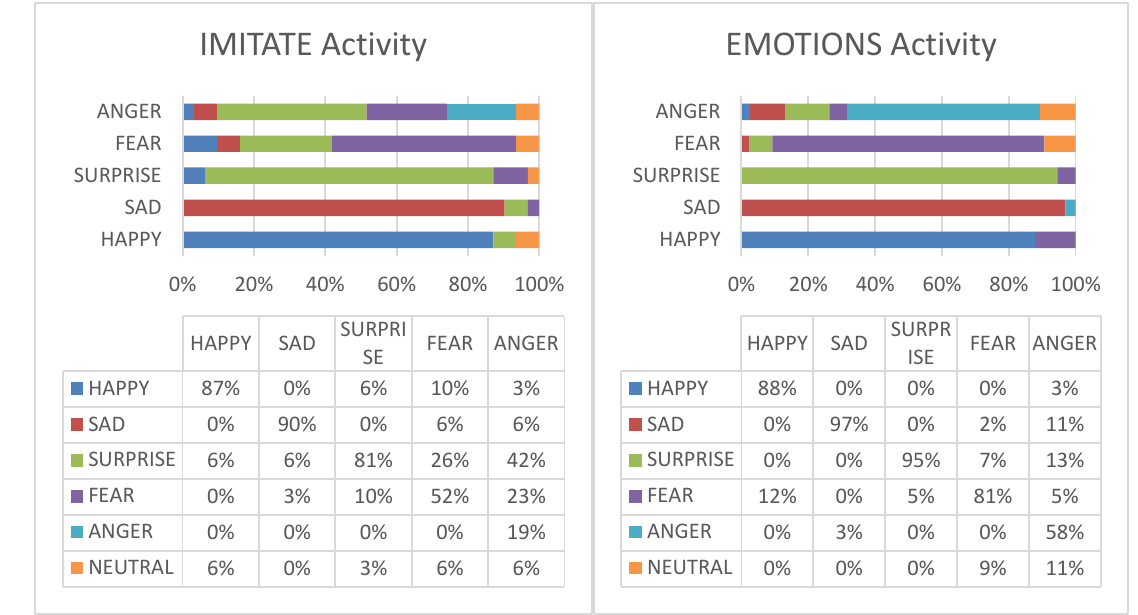
Figure 4. Results of the IMITATE and EMOTIONS game scenarios obtained with thirty-one typically developing children.